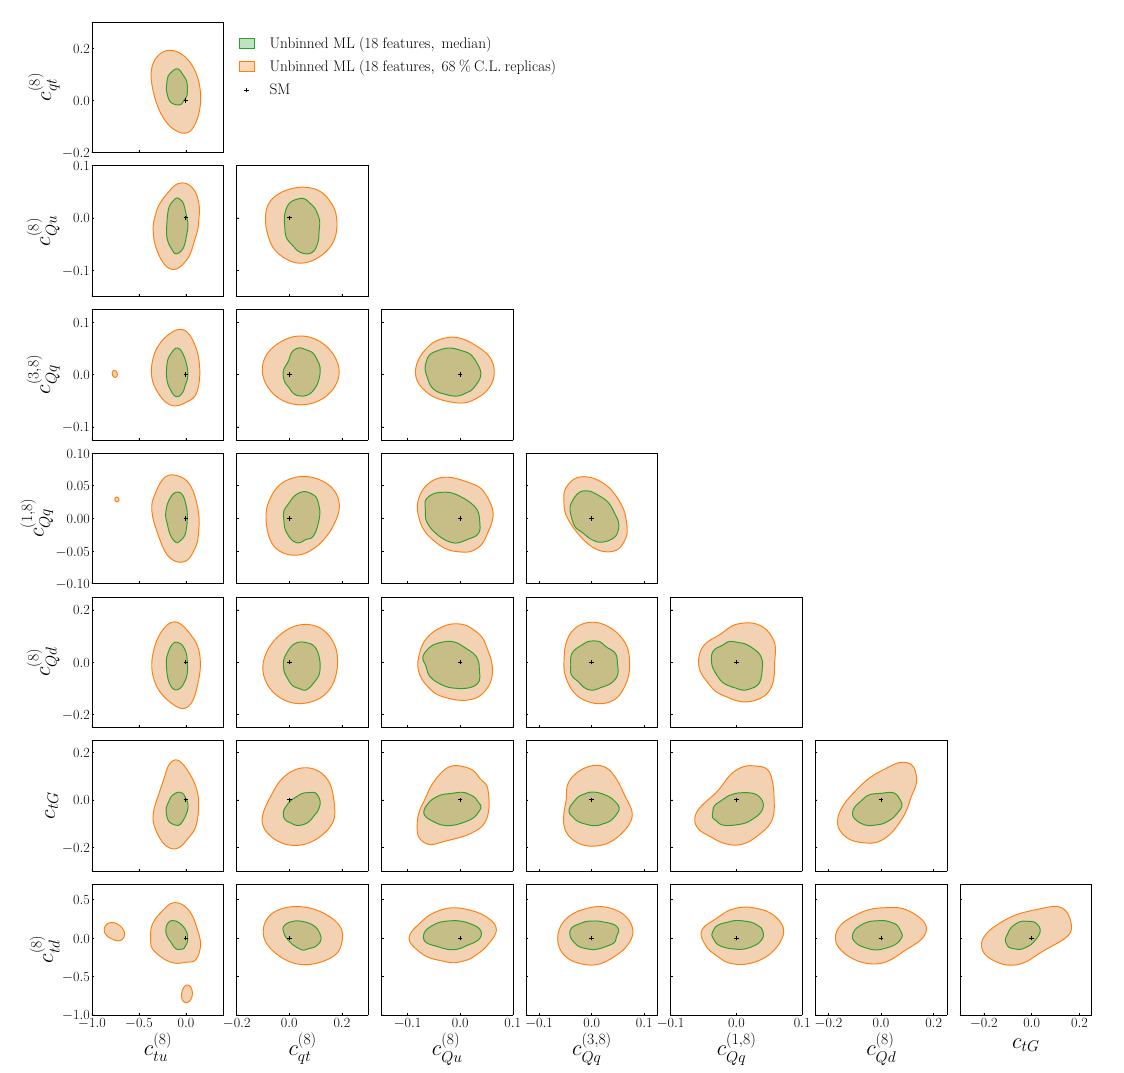
Figure 18. Same as figure 14 for the 68% CL contours in the EFT parameters obtained with the un- binned multivariate observable for particle-level top-quark pair production. We compare the bounds obtained from the median of the replica distribution of the likelihood ratio parametrization, as done in figure 14, with the corresponding bounds obtained taking into account the full replica